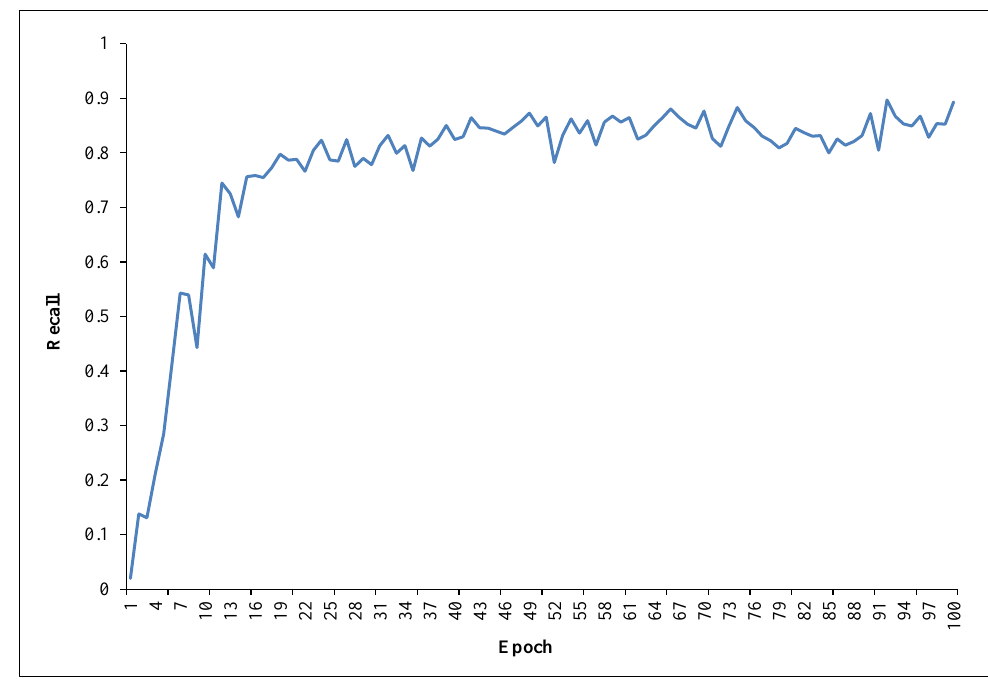
Figure 6. Yolov5s model Recall vs